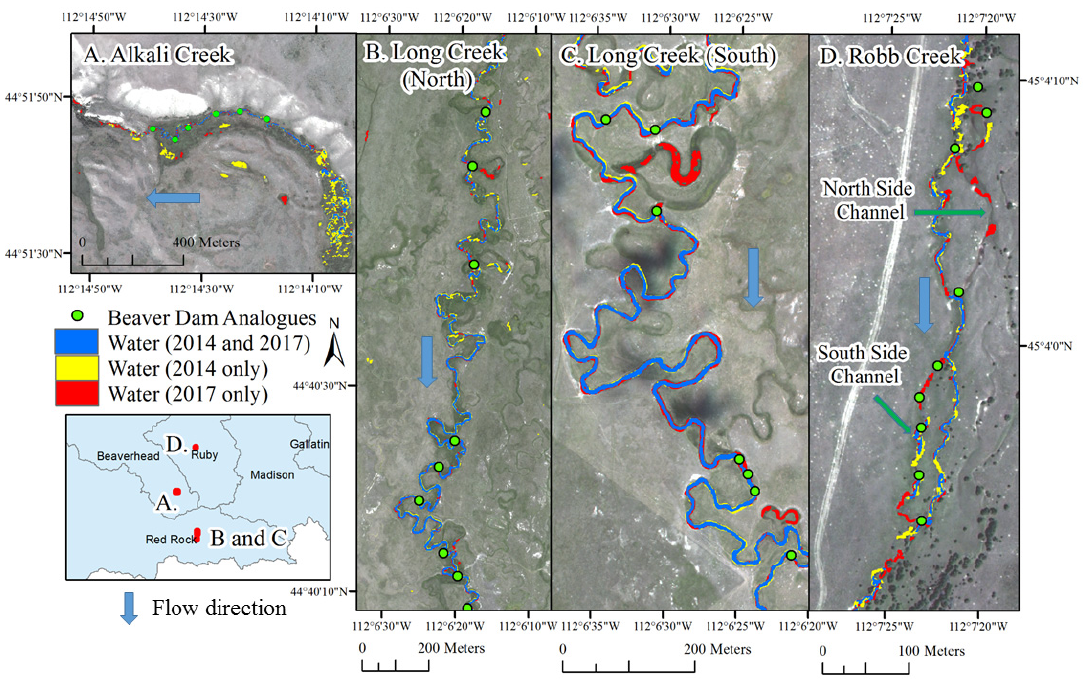
Figure 8. Change in stream surface area between the most upstream and most downstream beaver dam analogues (BDAs) along ( A ) Alkali Creek; ( B ) Long Creek (North); ( C ) Long Creek (South); and ( D ) Robb Creek. Copyright DigitalGlobe, 2014.